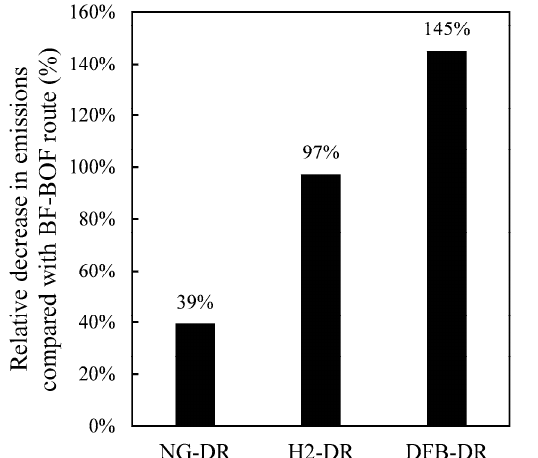
Figure 5. Decrease in CO 2 emissions relative to the BF–BOF route for the DFB-DR route, compared with the NG-DR and H 2 -DR routes. Table 9. CAPEX and OPEX for the DFB unit and gas-handling section, the DRI-EAF section, and the electrolysis section, for a plant that produces 1 Mt steel per year. The OPEX does not include the costs for biomass and electricity, nor does it account for revenues associated with negative CO 2 emissions. However, it accounts for the cost of the iron